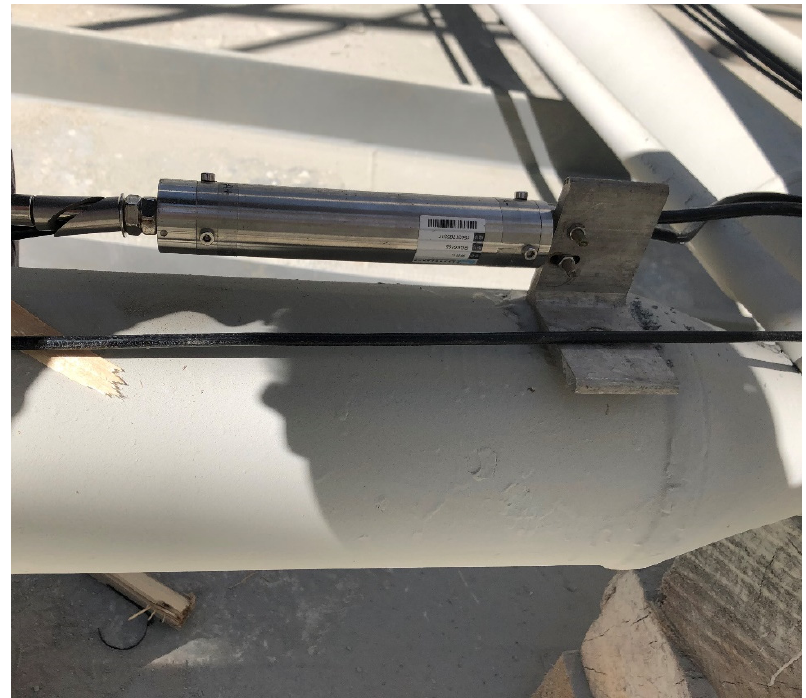
Figure 4. Horizontal single-axis inclinometer. The layout scheme of each monitoring section (red) is shown in Figure